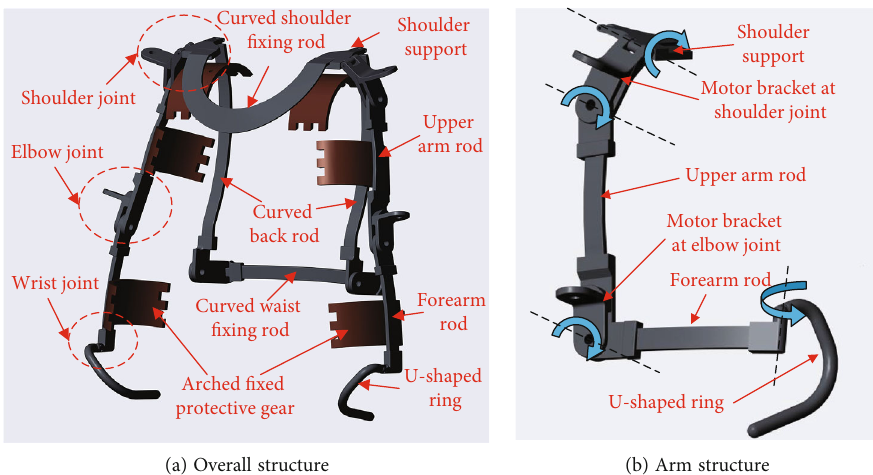
Figure 1: The structural design of the upper limb exoskeleton